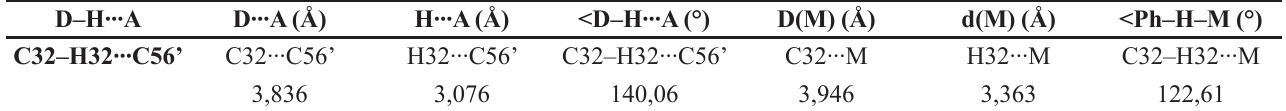
TABLE II - Geometric parameters for the non-classical aromatic hydrogen bonds (C-H ∙∙∙ Ph) of the complex dimers D–H∙∙∙A